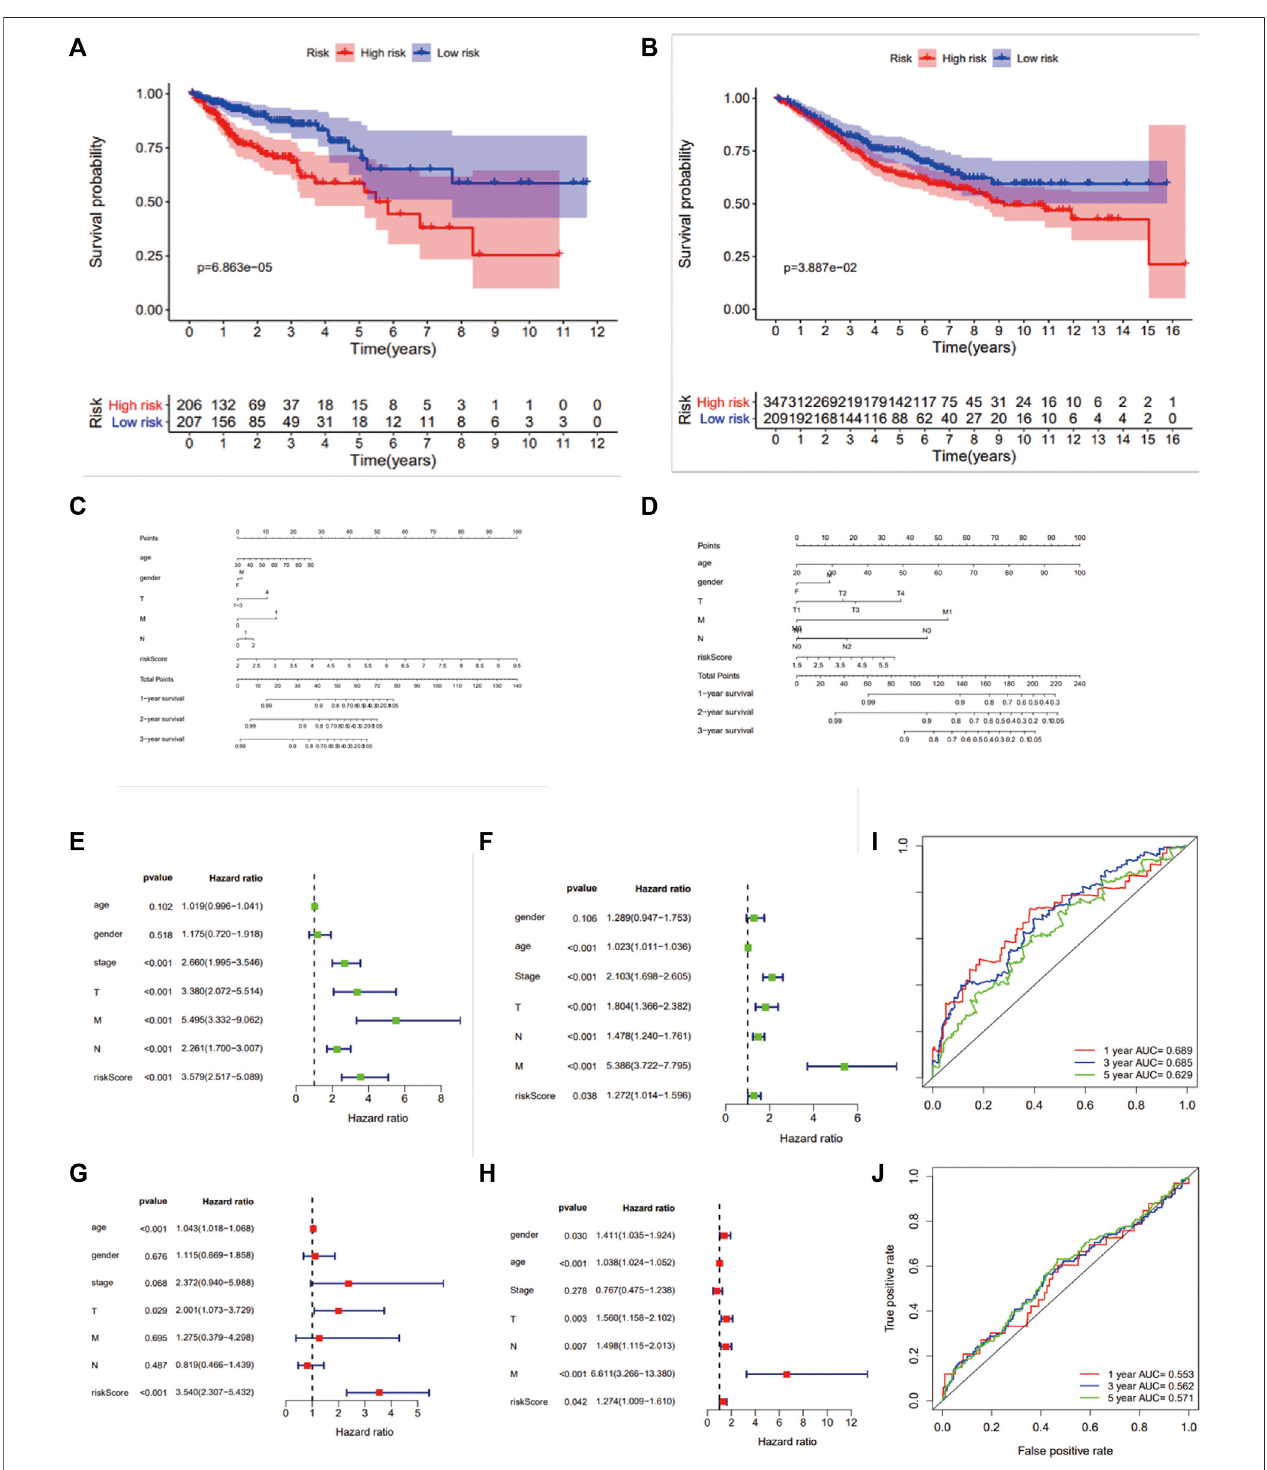
FIGURE 4 | Survival analysis and ROC analysis of the 7-gene prognostic signature. Kaplan – Meier survival curves of OS (A,B) , OS predictive nomogram (C,D) , univariate (E,F) and multivariate Cox proportional hazards regression (G,H) and ROC curves (I,J) in patients with colon carcinoma in TCGA and GSE39582.